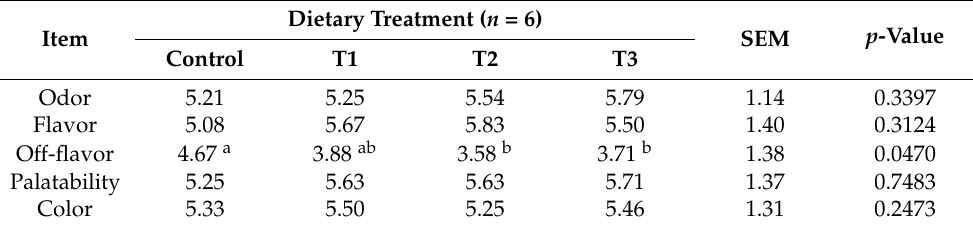
Table 5. Effects of Mentha arvensis (MA) and Geranium thunbergii (GT) on egg sensory evaluation.